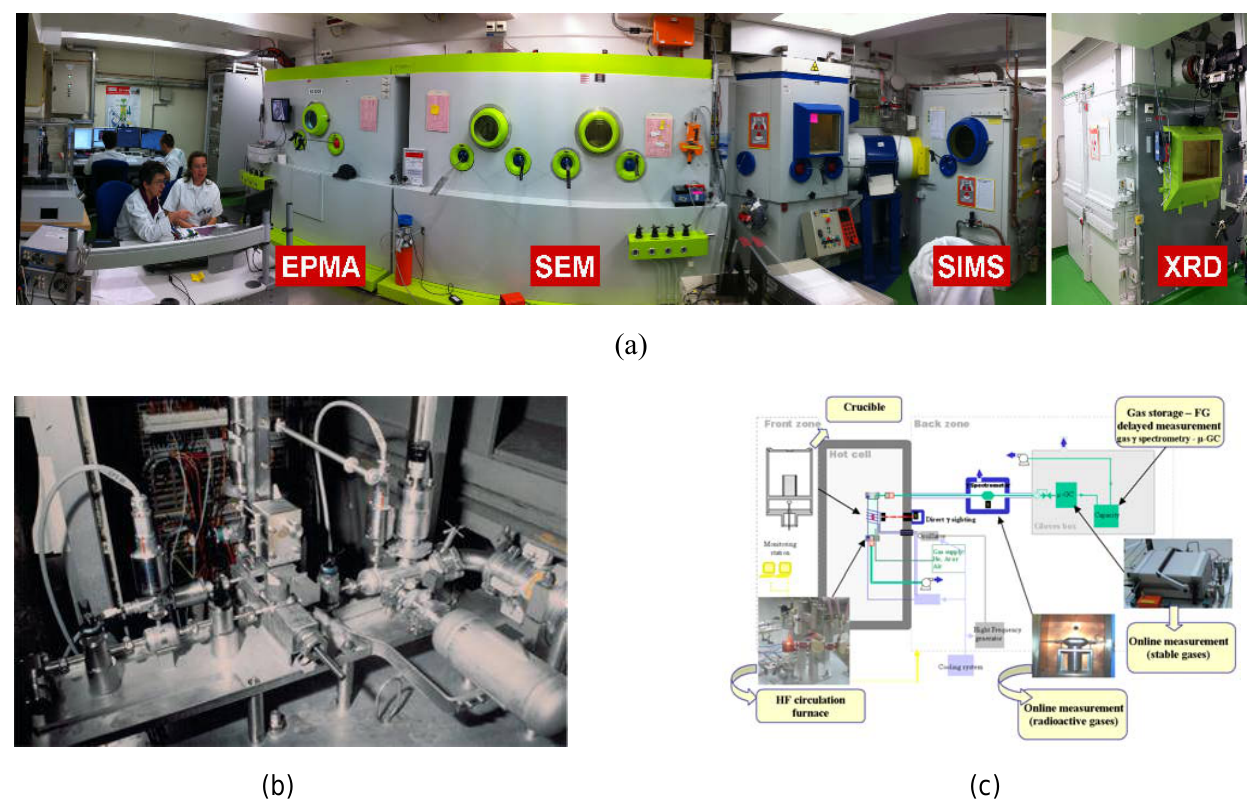
Fig. 1: LECA-STAR Hot-cell capabilities; (a) µ-analysis laboratory; (b) puncturing facility; (c) Annealing tests facility (MERARG